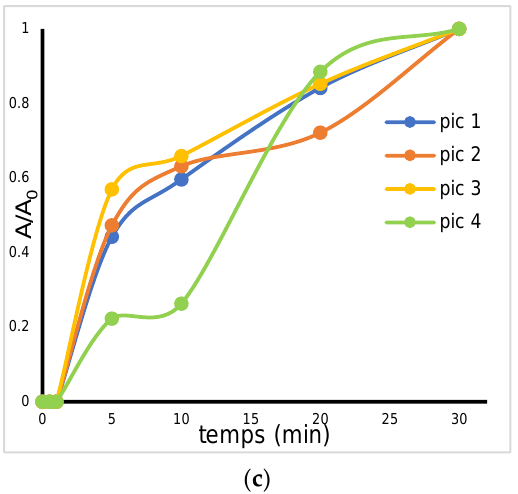
Figure 6. Evolution of the relative HPLC peak area ratio (P A /P Ao ) of the ozonation intermediates during non − catalytic ozonation of the aqueous solutions of DAZ (a), DCF (b) and BPA (c) at room temperature. V = 30 mL, Ozone throughput = 600 mg h −1 ; Initial concentration of organic substrate = 30 mg L −1 .